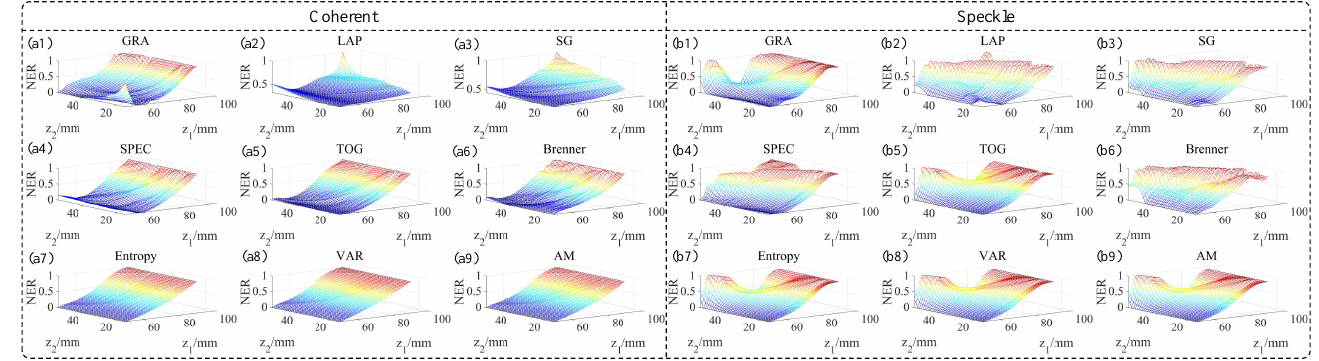
Figure 10. CEFs experimental results of simultaneous scanning of object and image distances: ( a1 – a9 ) display the CEF curves under coherent illumination; ( b1 – b9 ) display the CEF curves under speckle illu- mination.